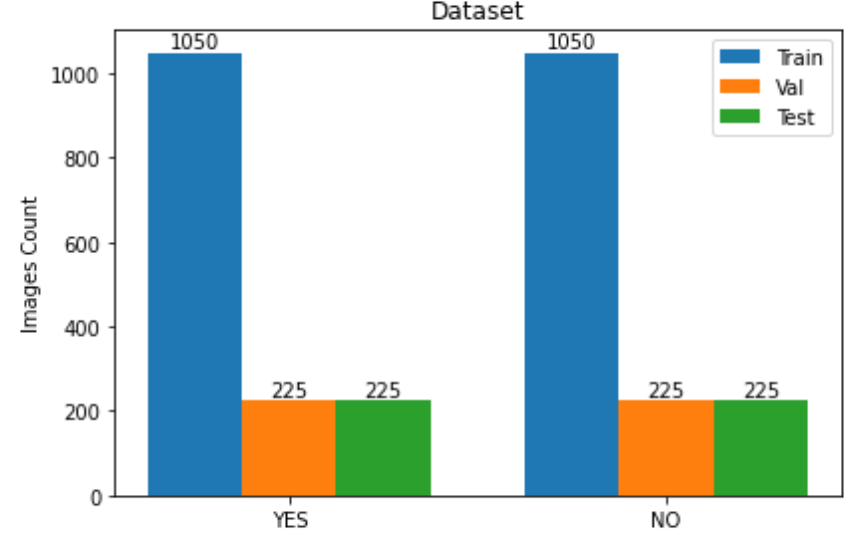
Figure 4. Presents the testing and training data of the brain tumor dataset. Table 1. The brain dataset description.